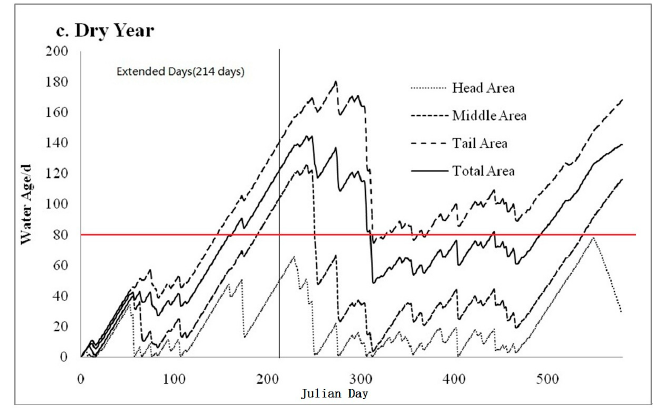
Figure 6. Time series of simulated water age in the years of wet ( a ), average ( b ), and dry ( c ) in CTR. In order to understand the spatial distribution of water ages in wet, average and dry years, the 7th day of July was selected as a representative day in the algal bloom season for further analysis as shown in Figure 7. In a wet year, water age in the tail and middle area was less than 1 d, and ranged between 1 and 3 d in the head area. However, water age in the downstream of the tributaries connecting to the head area was much higher than that in the reservoir, reaching 70 d. Similarly, in average and dry years, water ages increased along the main channel from upstream to downstream and relatively higher water ages appeared in the head areas as well. However, the values of water ages in average and dry years were significantly higher than that in the wet year. For example, the water ages in the head areas ranged from 50 to 100 days in average year, and 90–200 days in dry year, respectively. Thus, weather condition had a great impact on the temporal and spatial distribution of water ages in the reservoir.